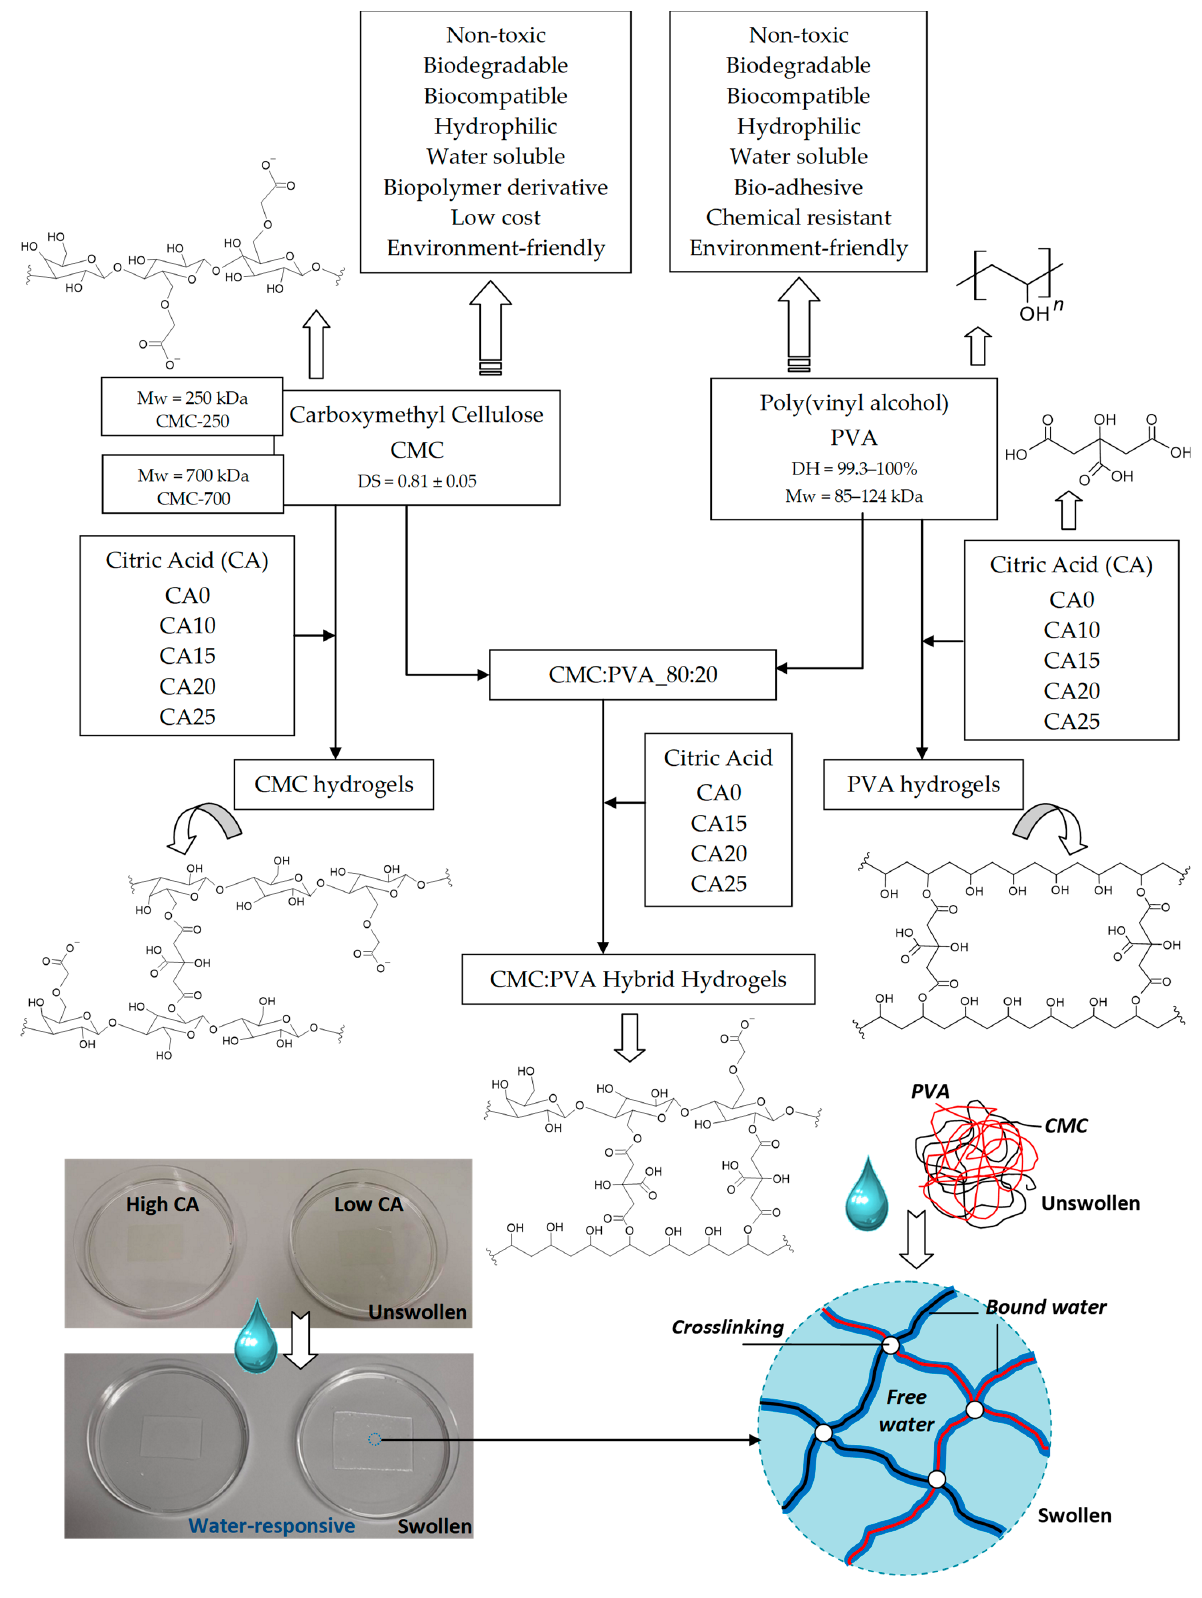
Figure 1. Schematic representation of the experimental design of bioengineered water-responsive CMC hydrogels, PVA hydrogels, and CMC:PVA hybrid hydrogels.